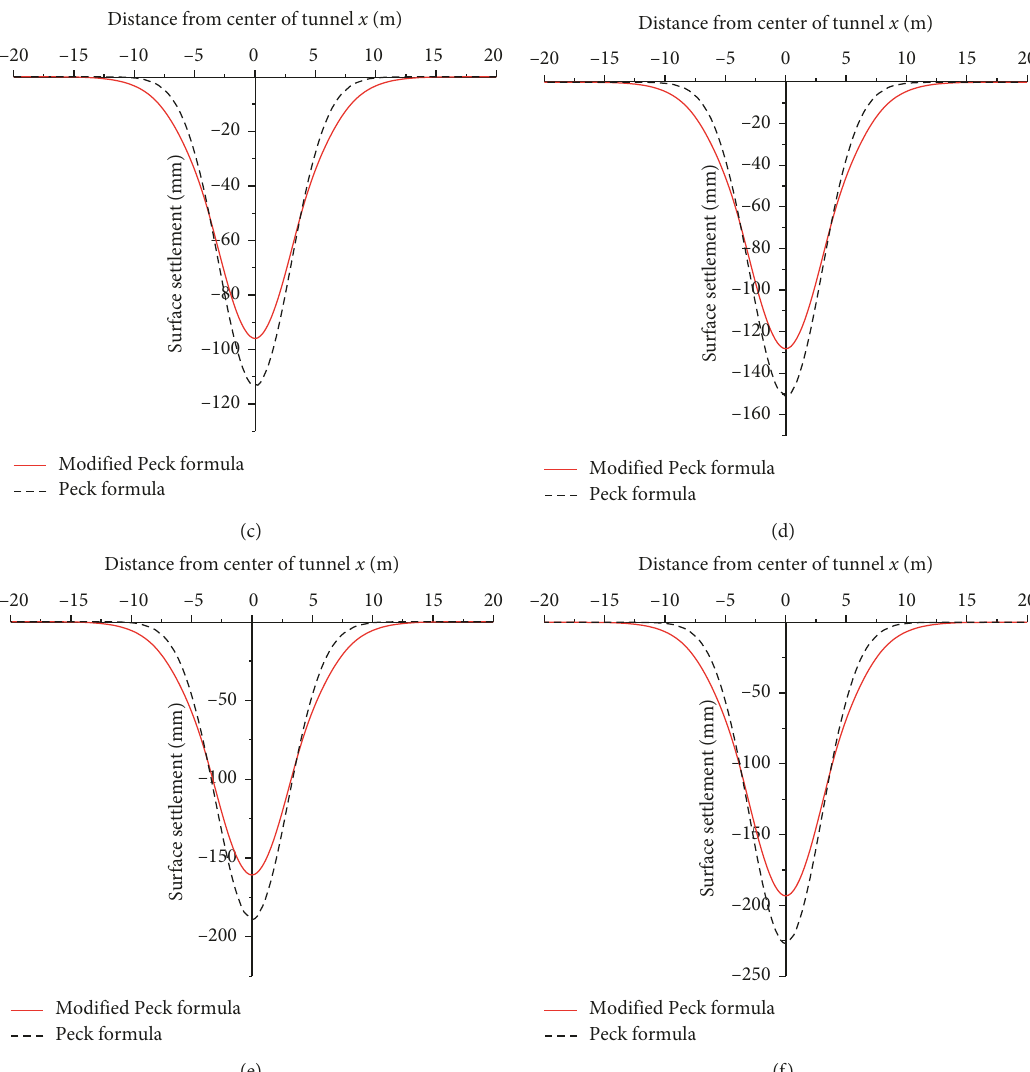
� 1%; (b) v � 2%; (c) v � 3%; l l l